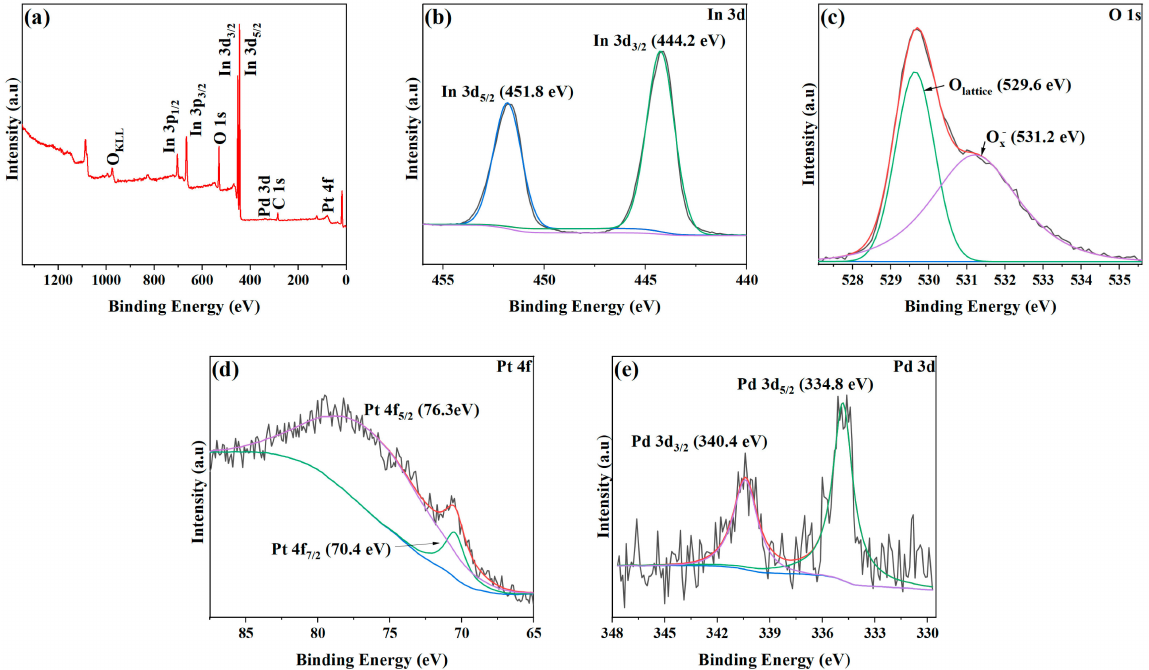
Figure 4. XPS spectra of 1 at% Pd/Pt-In 2 O 3 . ( a ) Survey spectrum and high-resolution XPS spectra: ( b ) In 3d, ( c ) In 3d, ( d ) Pt 4f, and ( e ) Pd